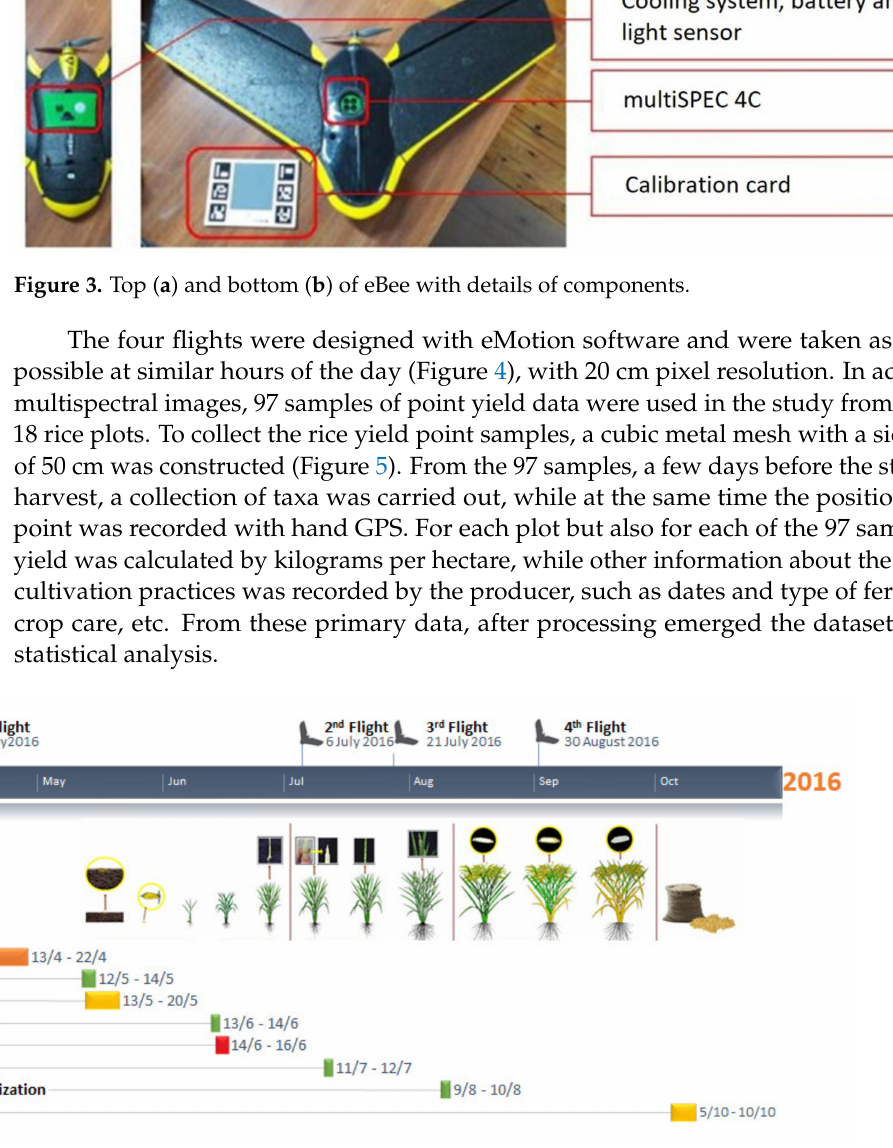
Figure 4. Stages of development of rice cultivation, cultivation practices of the Chalastra area, and the dates of the UAV